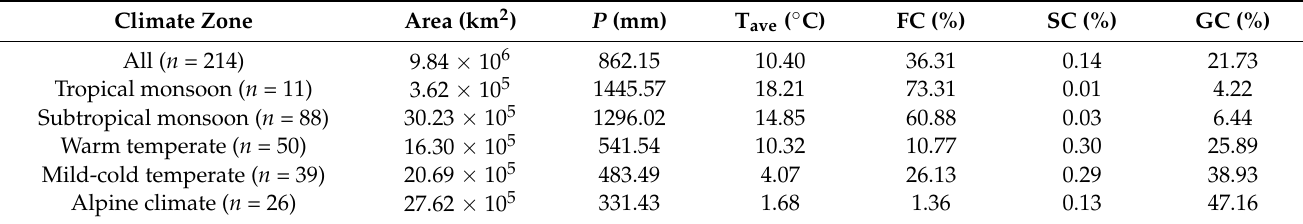
Figure 2. The forest coverage in 214 watersheds across six climate zones in China. Table 1. The vegetation coverage across six climate zones in China.